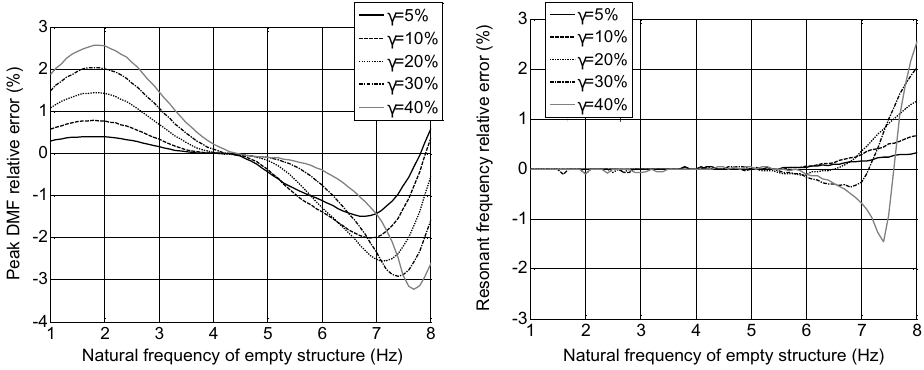
Fig. 9. Peak DMF relative error (left) and resonant frequency relative error (right) for equivalent 3DOF system.